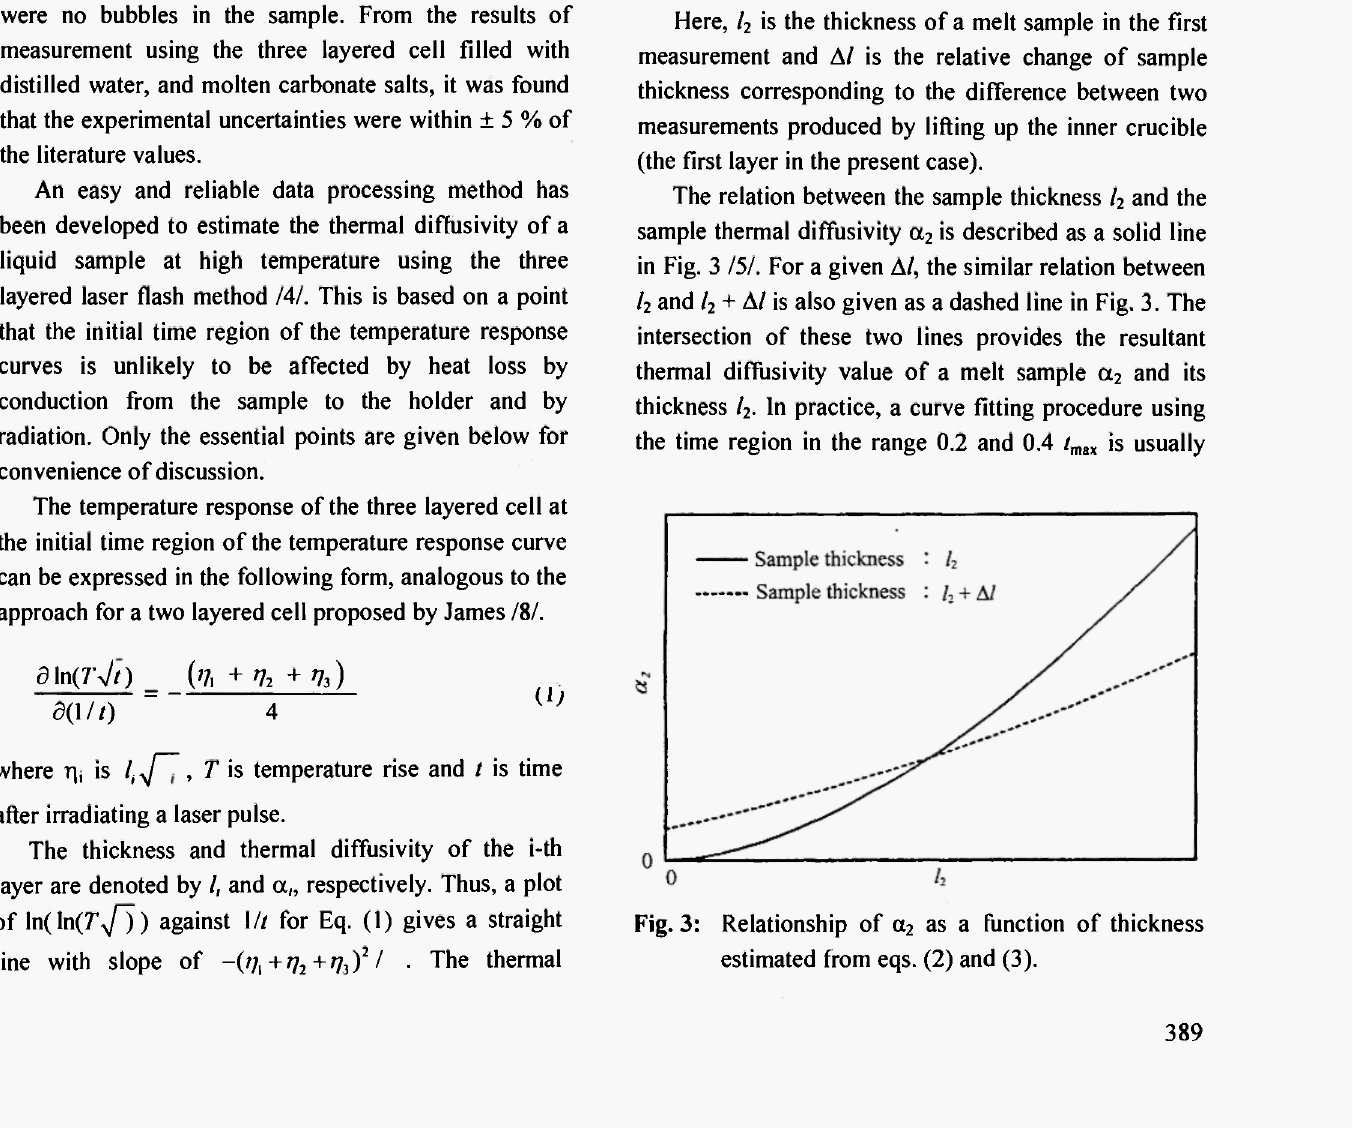
Fig. 3: Relationship of a 2 as a function of thickness estimated from eqs. (2) and